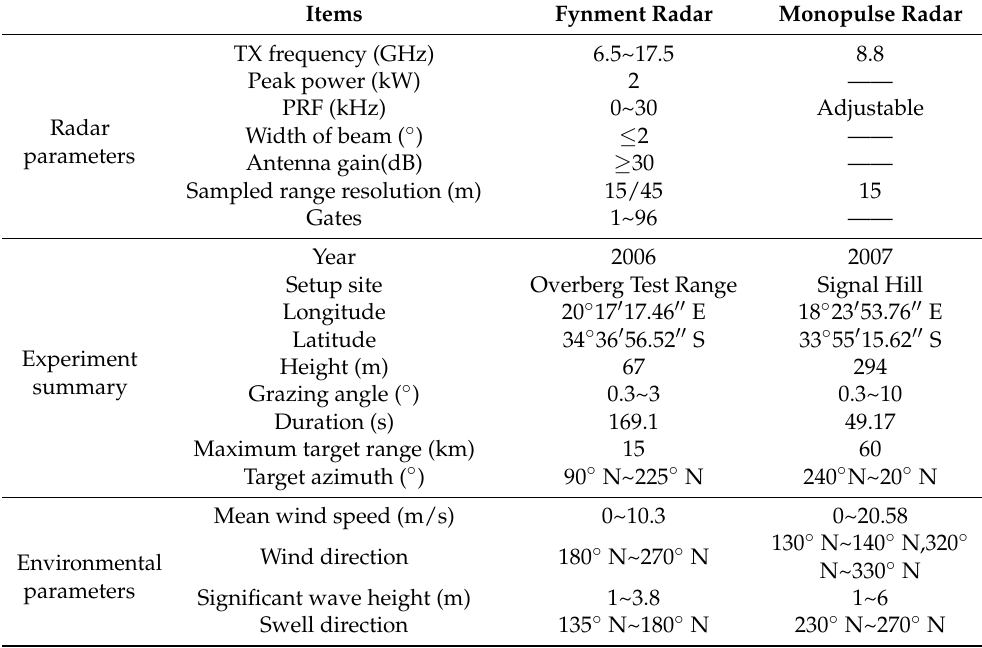
Table 4. CSIR trial radar and experimental